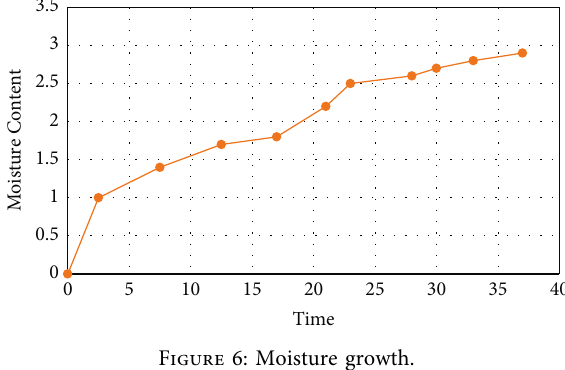
Figure 6: Moisture growth.